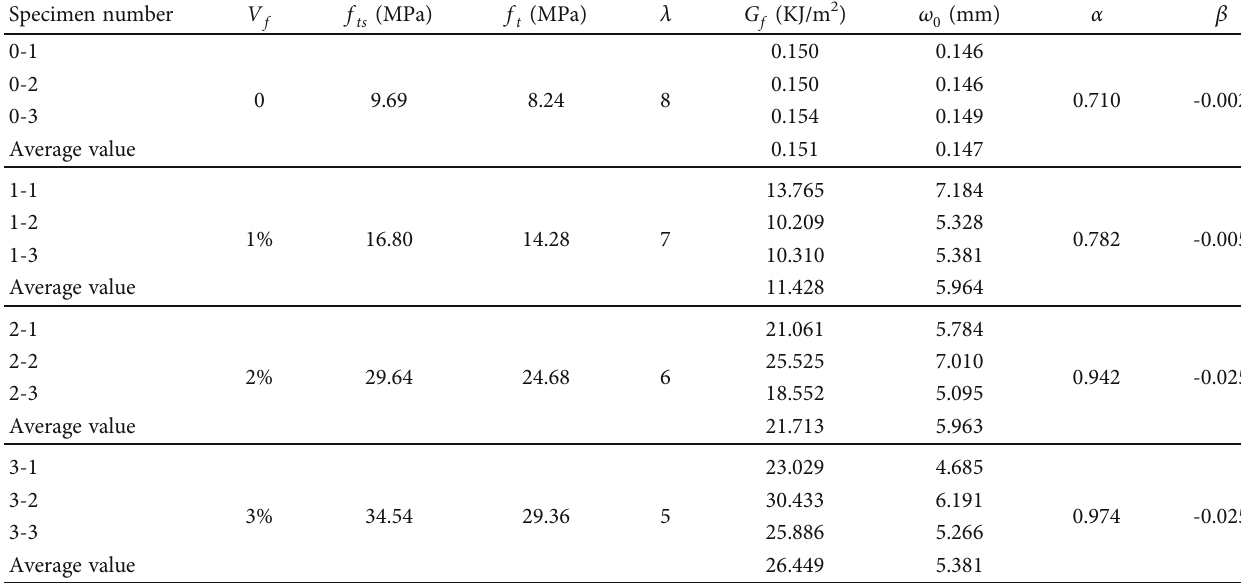
Table 2: Related indexes of softening curve for reactive powder concrete.